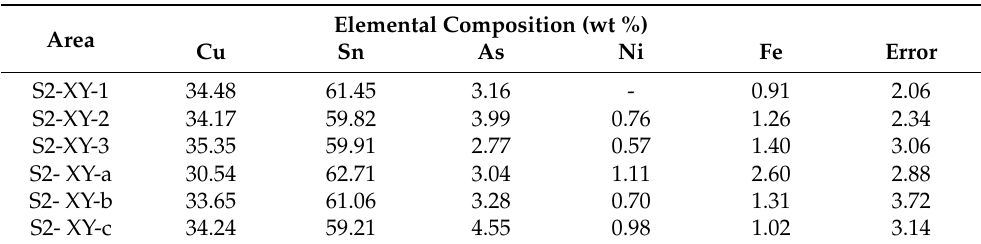
Table 5. Elemental chemical composition of the S2-XY-1, S2- XY-2, S2- XY-3, S2-XY-a, S2- XY-b and S2- XY-c